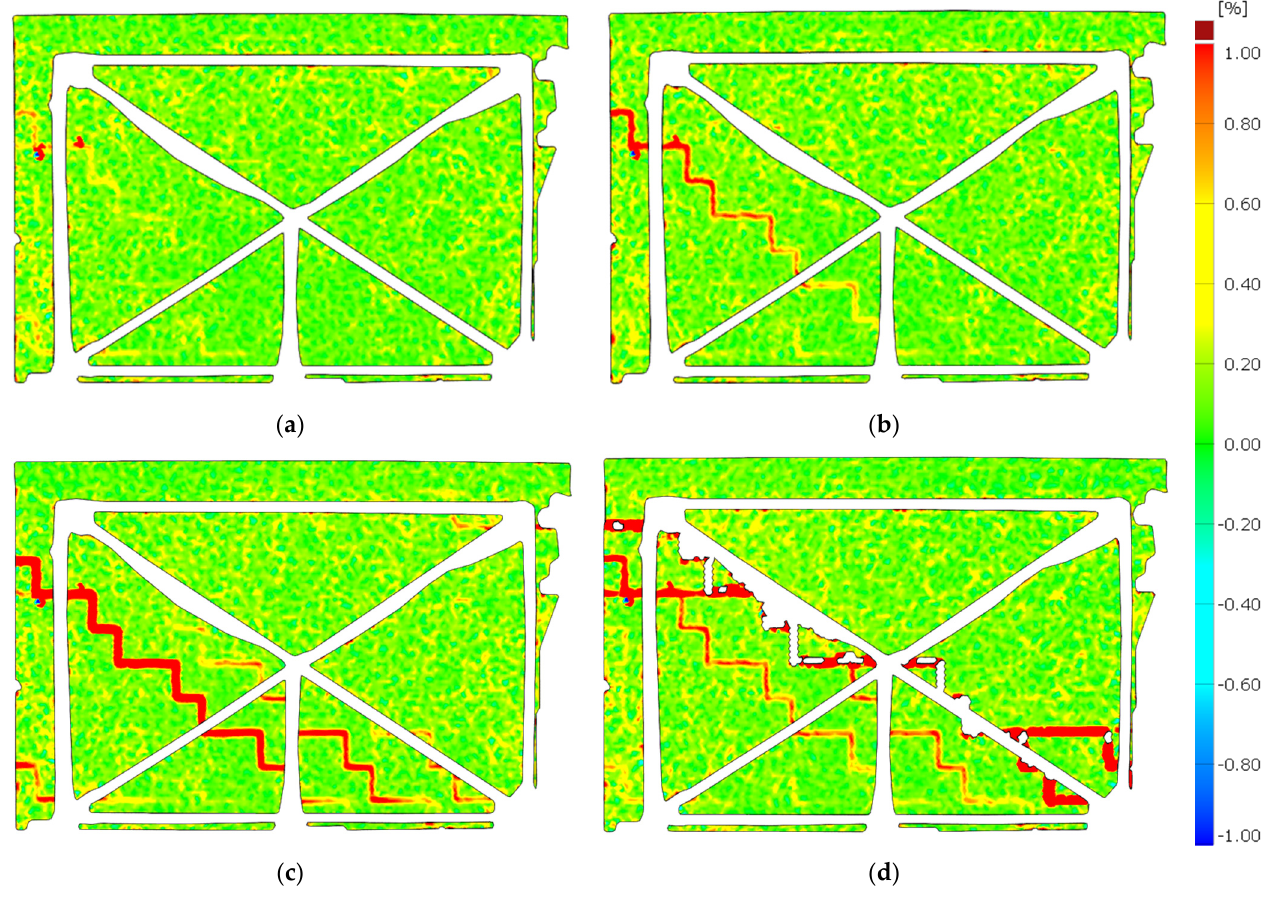
Figure 13. The crack propagation—MW-AAC-010/2 model; ( a ) crack pattern— H x = 48.05 kN; ( b ) crack pattern— H x = 48.60 kN; ( c ) crack pattern— H x = 69.25 kN; ( d ) crack pattern— H x = 42.77 kN (post-peak behavior).